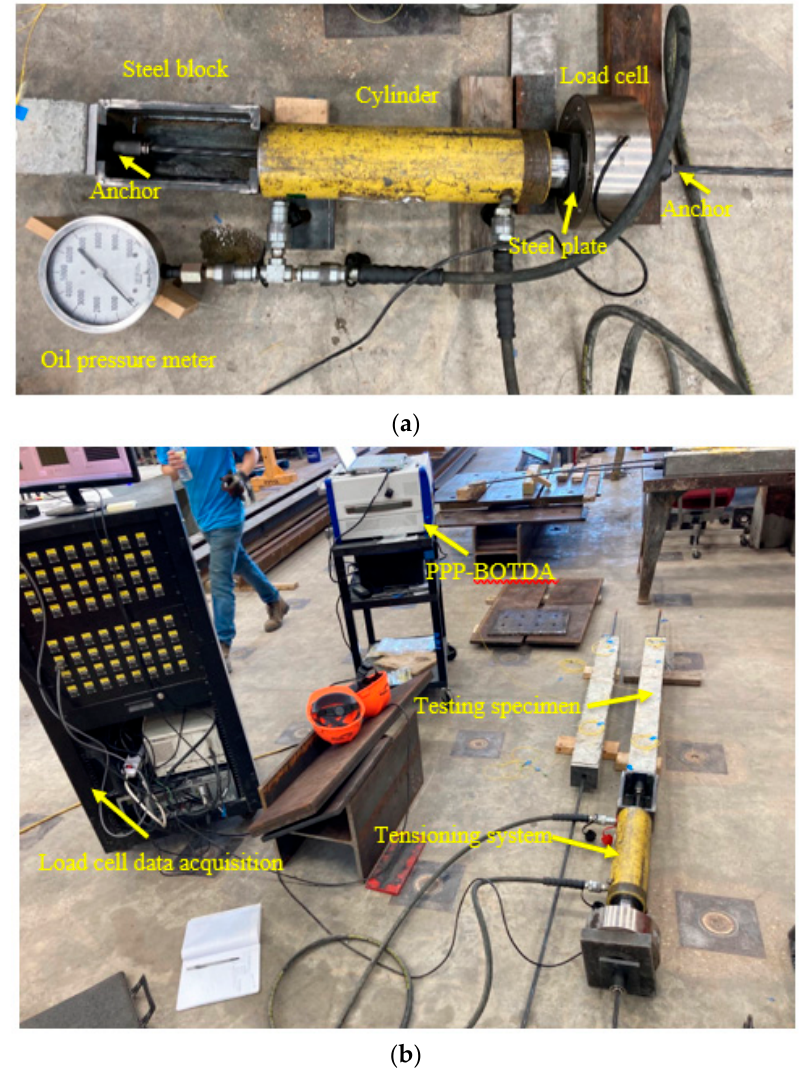
Figure 5. ( a ) New tensioning frame and ( b ) overall test setup.